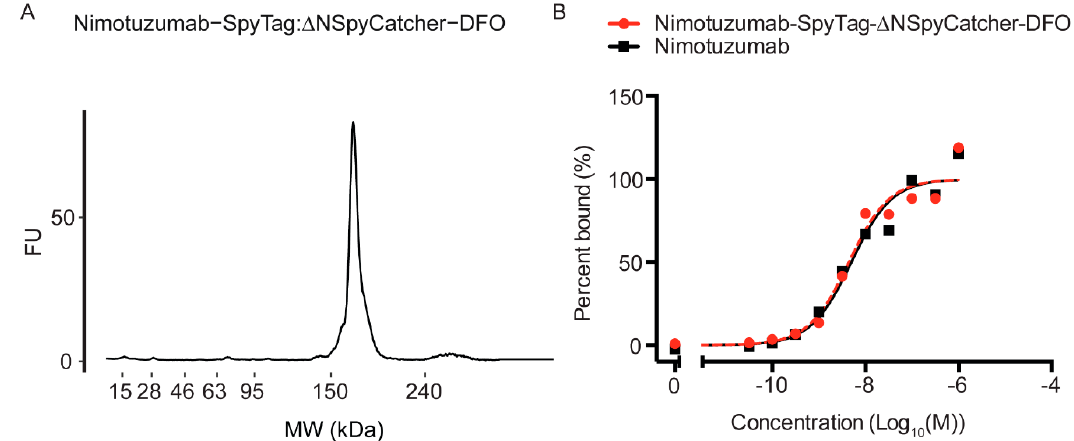
Figure 3. Quality control of the DFO conjugated nimotuzumab-SpyTag- ∆ N-SpyCatcher. ( A ) Figure3. QualitycontroloftheDFOconjugatednimotuzumab-SpyTag- ∆ N-SpyCatcher. ( A )Bioanalyzer Bioanalyzer showing the purity and molecular weight of DFO-nimotuzumab-SpyTag- ∆ N- showingthepurityandmolecularweightofDFO-nimotuzumab-SpyTag- ∆ N-SpyCatcher. ( B )Saturation SpyCatcher. ( B ) Saturation binding of DFO-nimotuzumab-SpyTag- ∆ N-SpyCatcher using flow binding of DFO-nimotuzumab-SpyTag- ∆ N-SpyCatcher using flow cytometry in epidermal growth cytometry in epidermal growth factor receptor (EGFR)-positive MDA-MB-468 breast cancer cells. factor receptor (EGFR)-positive MDA-MB-468 breast cancer